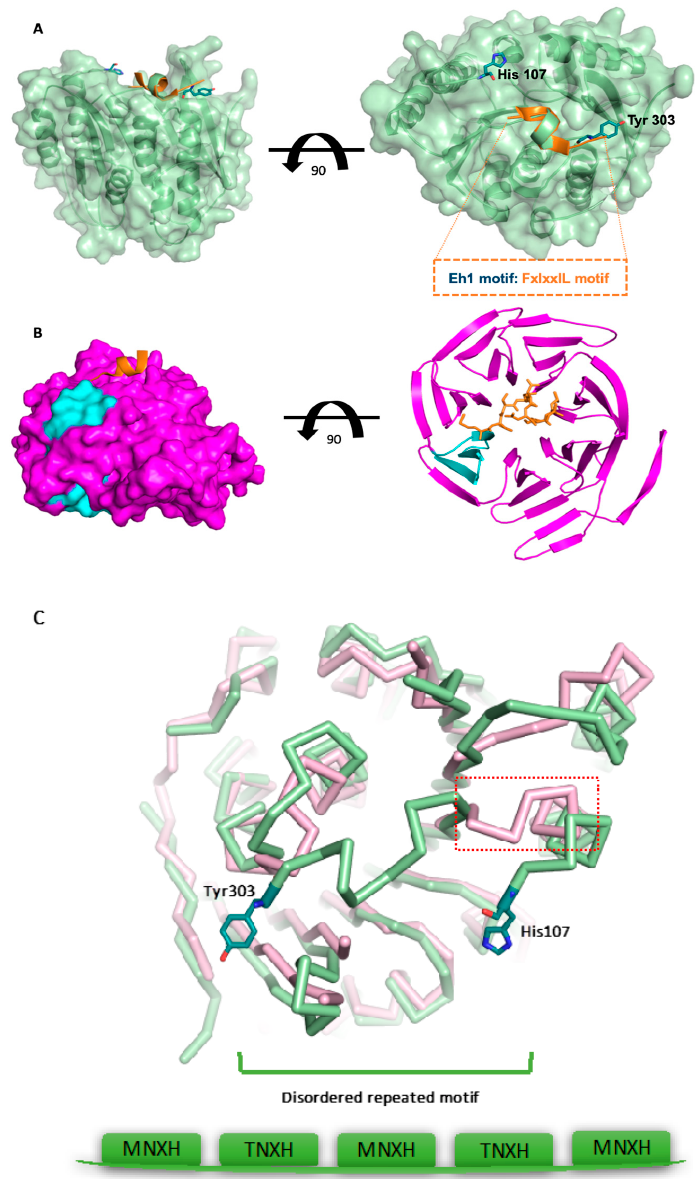
Figure 4. A surface-exposed epitope in Pf PdxK resembles the known Engrailed Homology1 (Eh1)